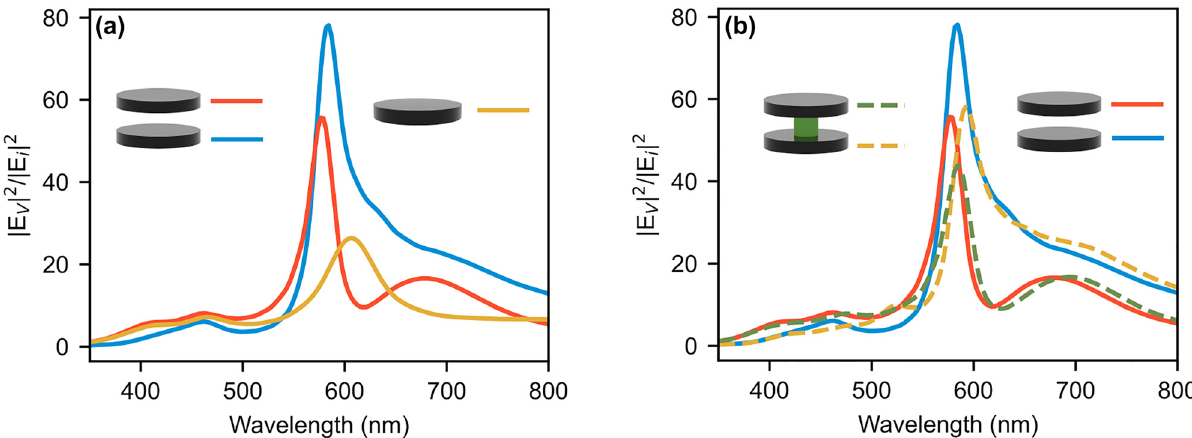
| | 2 . (a) Comparison of the energy inside each disk in the i